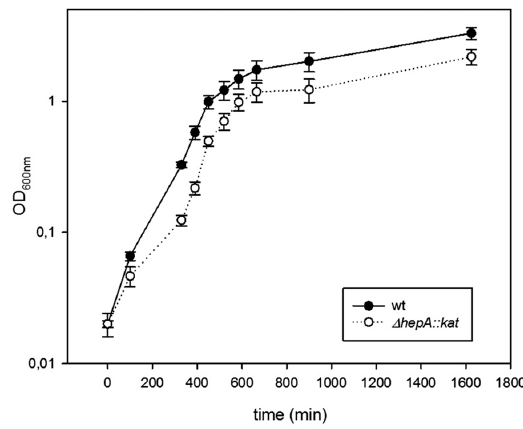
Figure 4. Mutants defective in HepA grow at low temperatures. Growth curves in TB medium at 60 °C of the wild-type strain (black circles), and its Δ hepA mutant (empty circle). Error bars represent the deviation of the mean value of three independent samples.